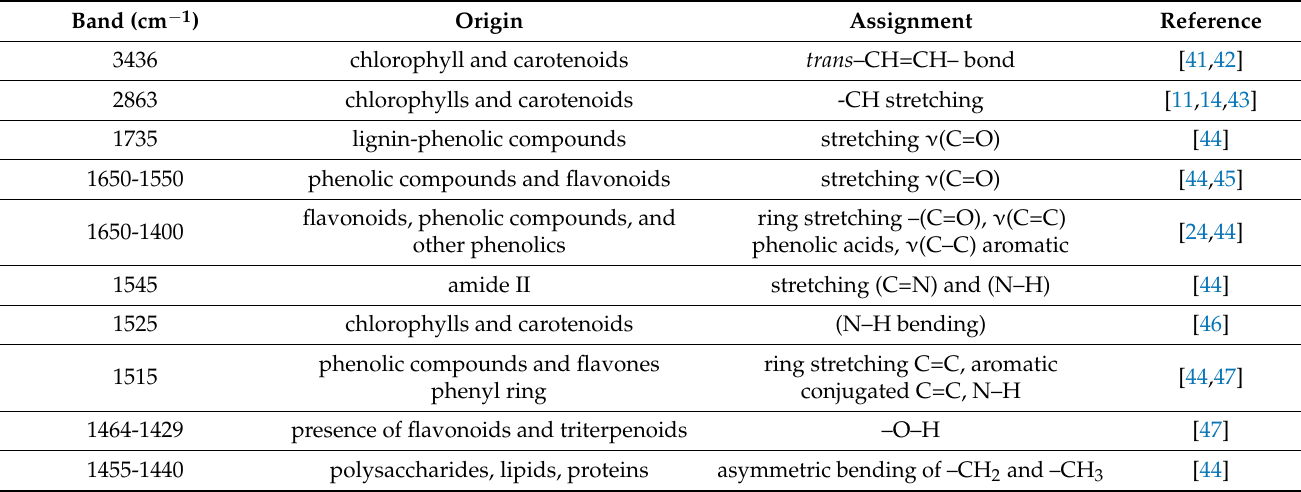
Table 5. Band assignments of ATR-FTIR spectra characteristic of the phenolic compounds and flavonoids in different spectra obtained by ATR-FTIR and the corresponding